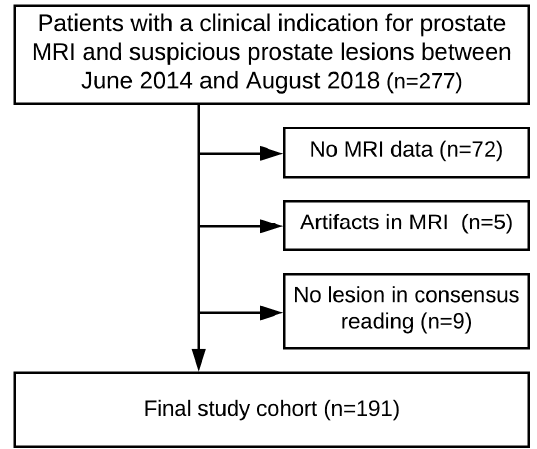
Figure 3. Consort flow diagram for patient inclusion.